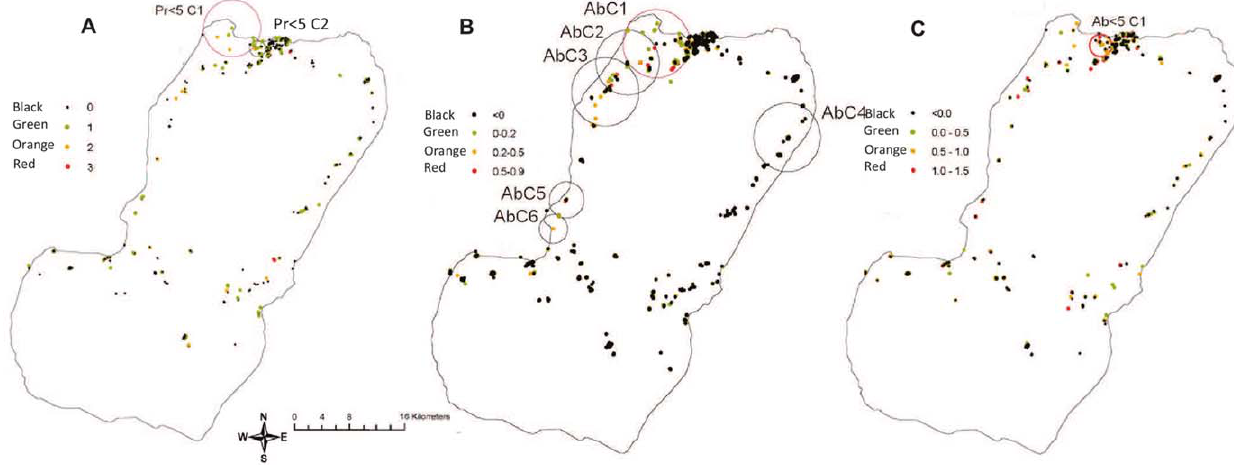
Figure 4. Spatial analyses of parasite positive individuals and anti- P.falciparum AMA-1 antibody responses. 4a Spatial distribution of parasite positive individuals under the age of 5 years. This age group was chosen to highlight children who had become infected since interventions began. Colour scale used to denote how many infections were present per household. Black dots are households with no infections in children under 5 years old. SaTScan was used to detect clusters (of no more than 5 km diameter) where there were higher numbers of cases than expected. The primary cluster (most significant cluster) is circled in red, with a secondary clusters circled in black (all p values less than 0.01 for clusters). 4b Spatial distribution of the residual mean log antibody responses to P.falciparum AMA-1 in all ages plotted by household. Red circle (AbC1) indicates a cluster of significantly higher than expected antibody responses detected using SaTScan. Secondary clusters (AbC 2–6) are circled in black. 4c Spatial distribution of the residual mean log antibody responses to P.falciparum AMA-1 in children under 5 plotted by household. Red circle (Ab , 5C1) indicates a cluster of significantly higher than expected antibody responses detected using SaTScan.